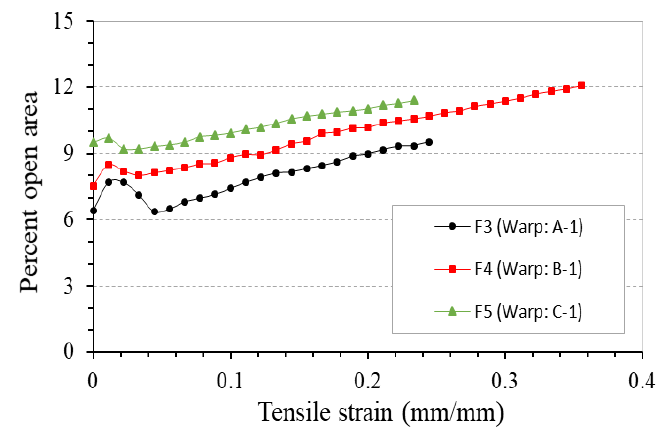
Figure 16. Percent open area-tensile strain curves of fabrics F3, F4, and F5.